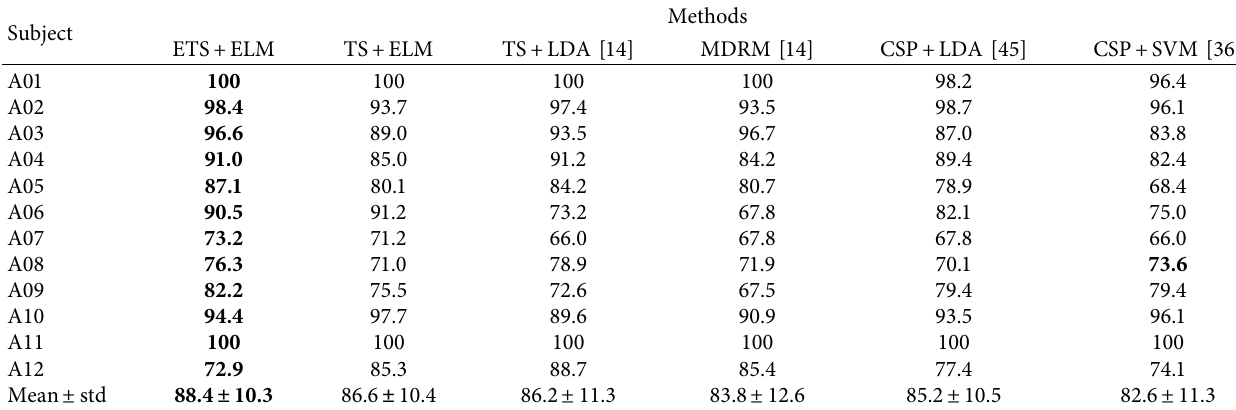
Table 3: Classification accuracy on in-house BCI dataset (%).